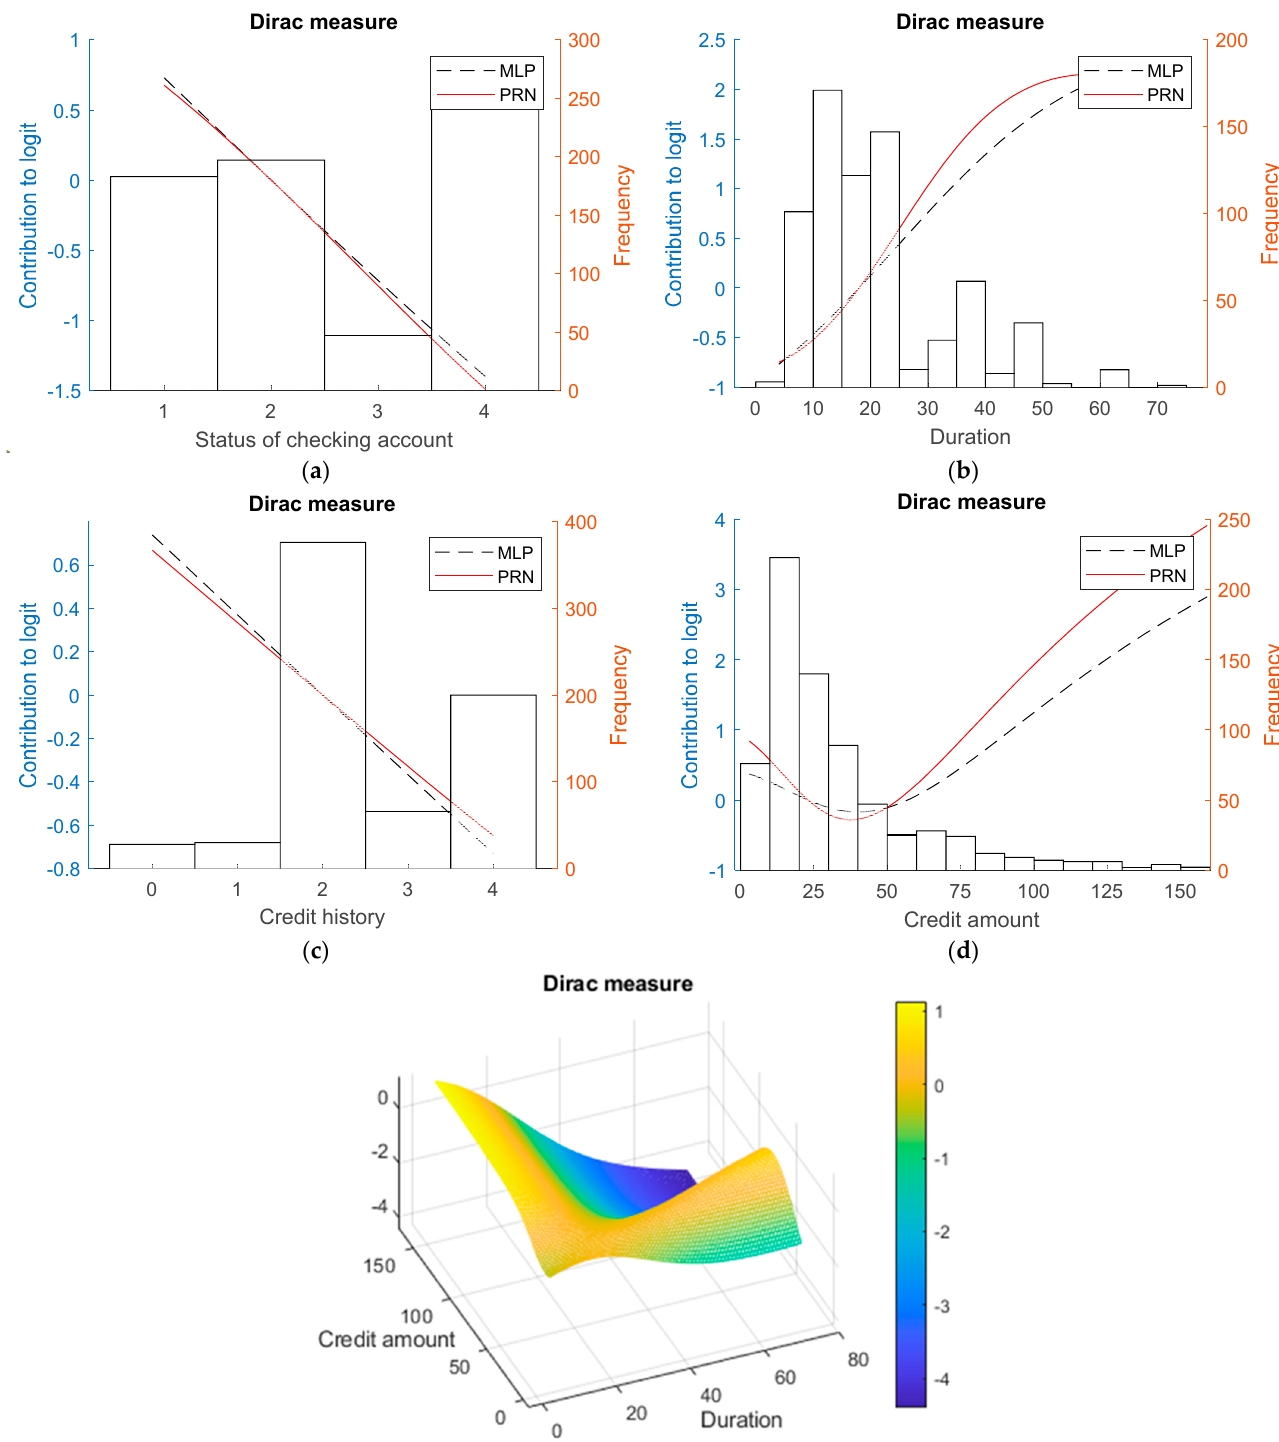
Figure 8. Partial responses for the German Credit Card data set, using the same notation as the previous figures. Four univariate responses and a bivariate response are shown namely for the covariates ( a ) Status of checking account, ( b ) Duration of loan, ( c ) Credit history and ( d ) Credit amount, together with ( e ) the pairwise interaction between Credit amount and Duration of loan.